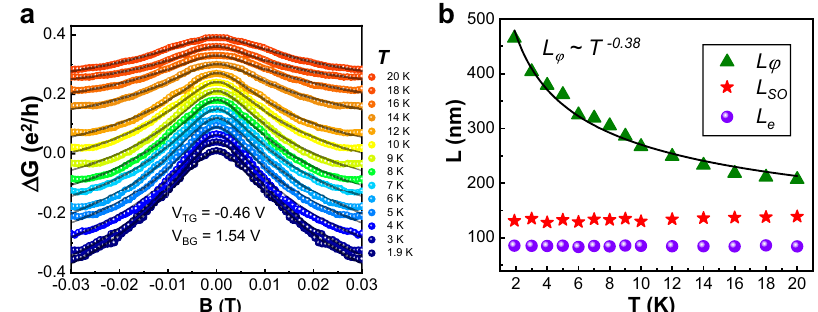
Fig. 5 Temperature-dependent magnetotransport measurements. a Low- fi eld magnetoconductance Δ G measured for the device at V BG ¼ 1 : 54V and V TG ¼ (cid:2) 0 : 46V , corresponding to a conductance value of ~9 e 2 / h and a dual-gate voltage value of V D = − 2 V, at different temperatures T . The bottom trace shows the measured magnetoconductance data at T = 1.9 K and all other measured magnetoconductance traces are successively vertically offset for clarity. b Phase coherence length L φ , spin – orbit length L SO , and mean free path L e extracted by fi tting the measured data to Eq. (1) as a function of temperature T . The black solid line is a power-law fi t to the extracted phase coherence length L φ , showing L φ ~ T − 0.38